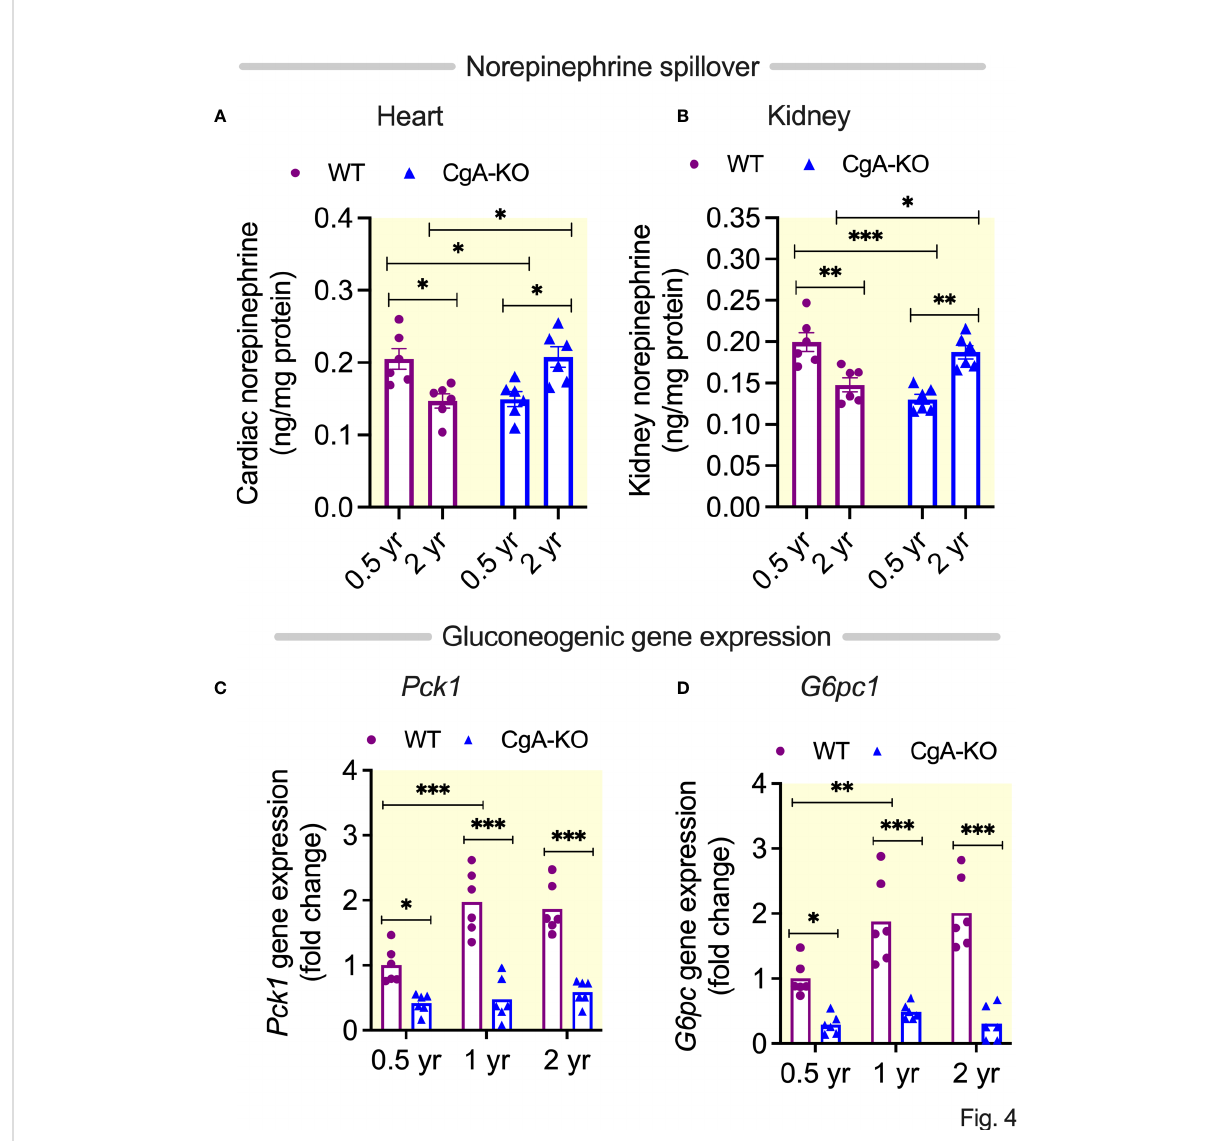
FIGURE 4 Spillover of norepinephrine and expression of gluconeogenic genes. Spillover of norepinephrine in (A) Heart, and (B) Kidney of 0.5, 1 and 2 yr old WT and CgA-KO mice. Expression of hepatic gluconeogenic genes: (C) Pck1 , and (D) G6pc . *P <0.05; **P <0.01; ***P